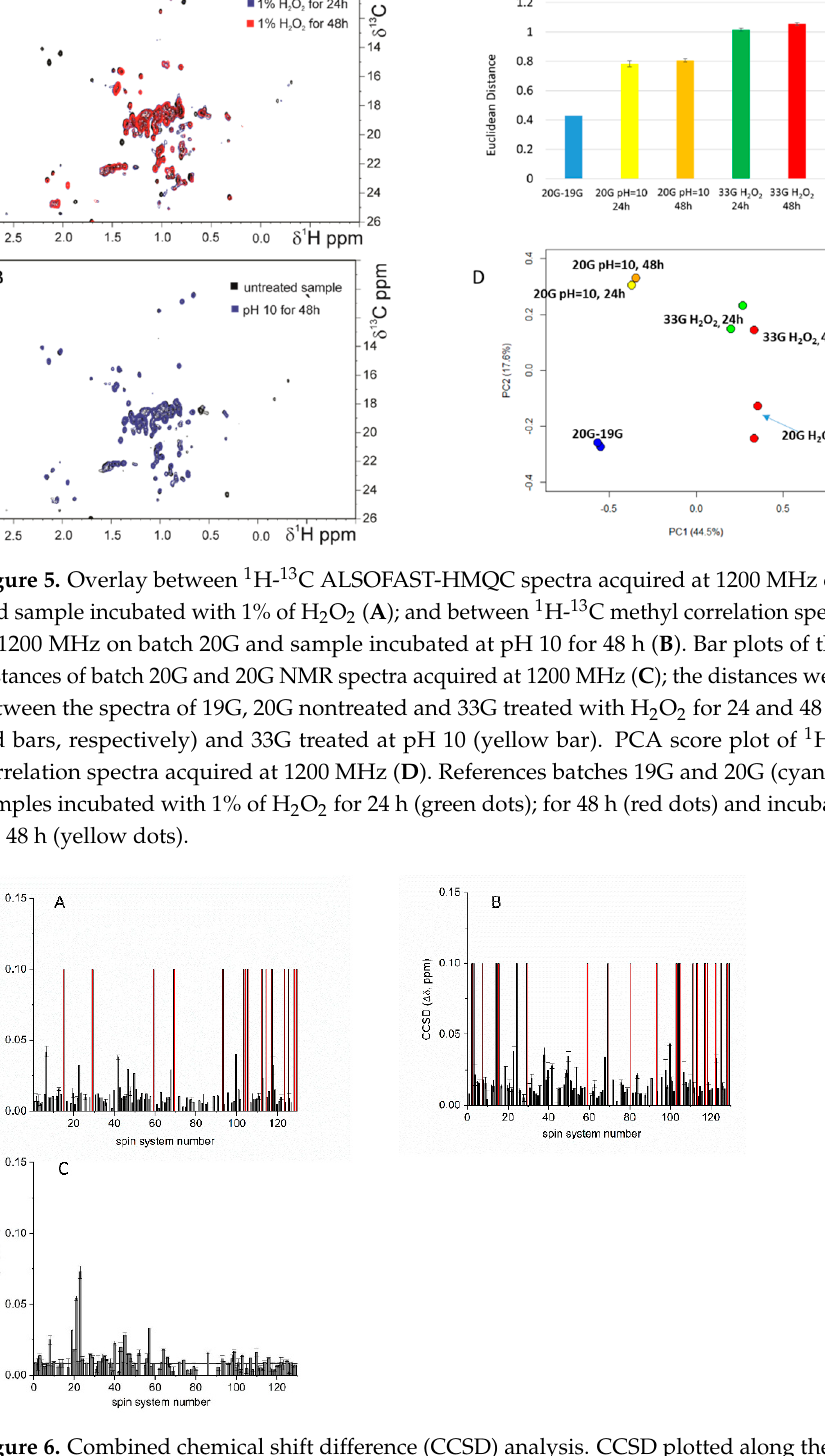
Figure 6. Combined chemical shift difference (CCSD) analysis. CCSD plotted along the spin system detected, calculated between batch 20G and sample incubated for 24 h with 1% of H 2 O 2 ( A ); between batch 20G and sample incubated for 48 h with 1% of H 2 O 2 ( B ); between batch 20G and sample incubated at pH 10 for 48 h ( C ). The lines represent the average CCSD values. The resonance positions from the 1 H- 13 C ALSOFAST-HMQC spectrum acquired on batch 20G were used as a reference. The red bars represent the methyl cross-peak of the spin systems that disappeared after H 2 O 2 -treatment.